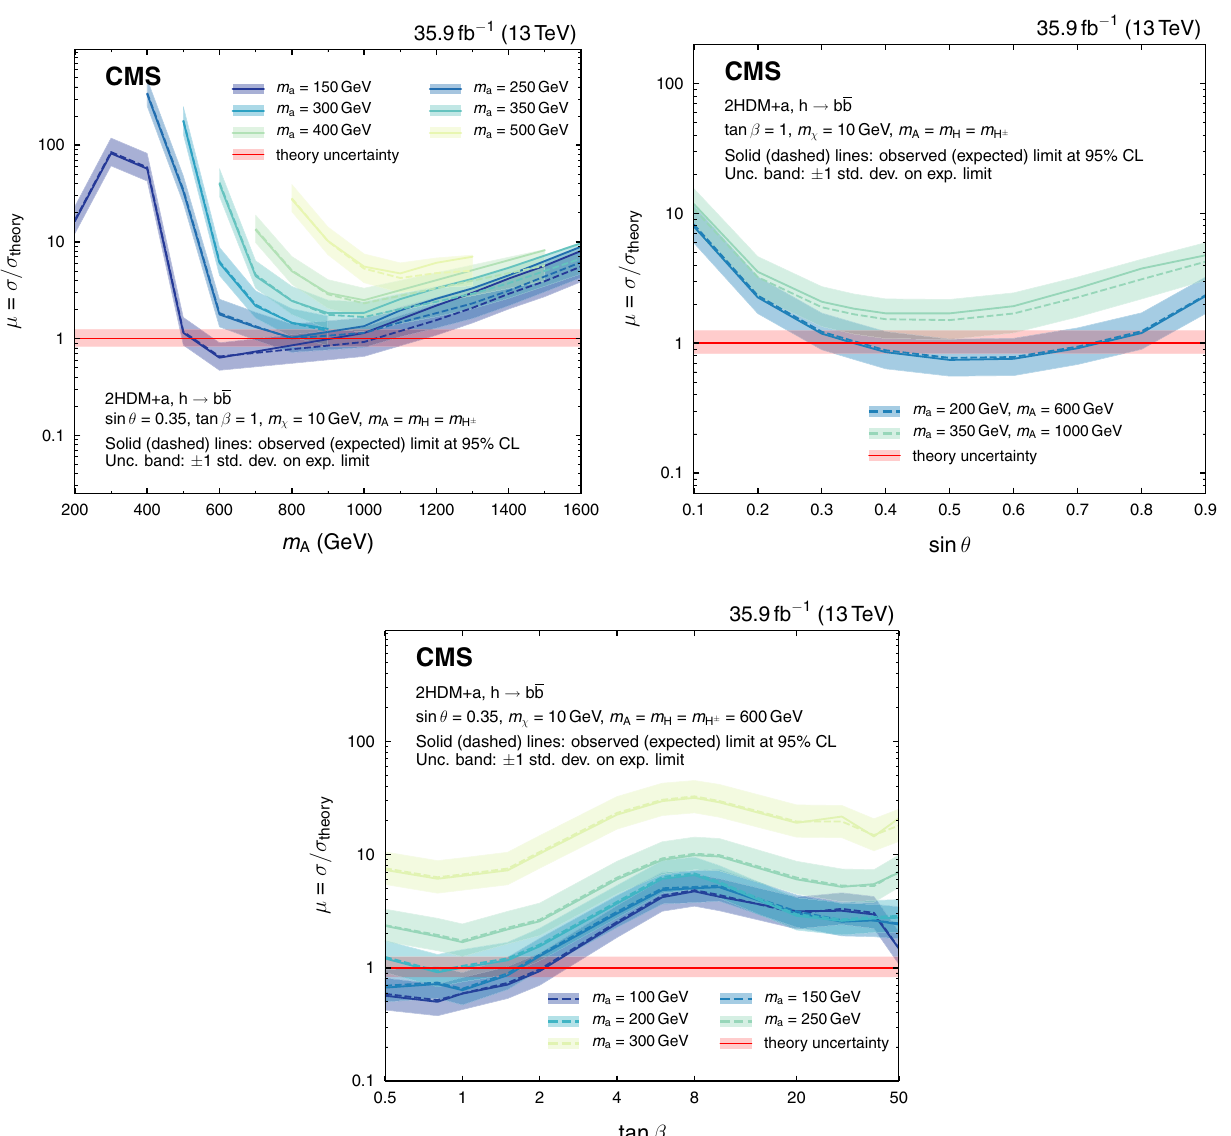
modelwhenscanning m A and m a (upperleft),themixingangle θ (upper right), or tan β (lower). The uncertainty in the computation of σ theory is 20% and is shown as a red band around the exclusion line at μ =